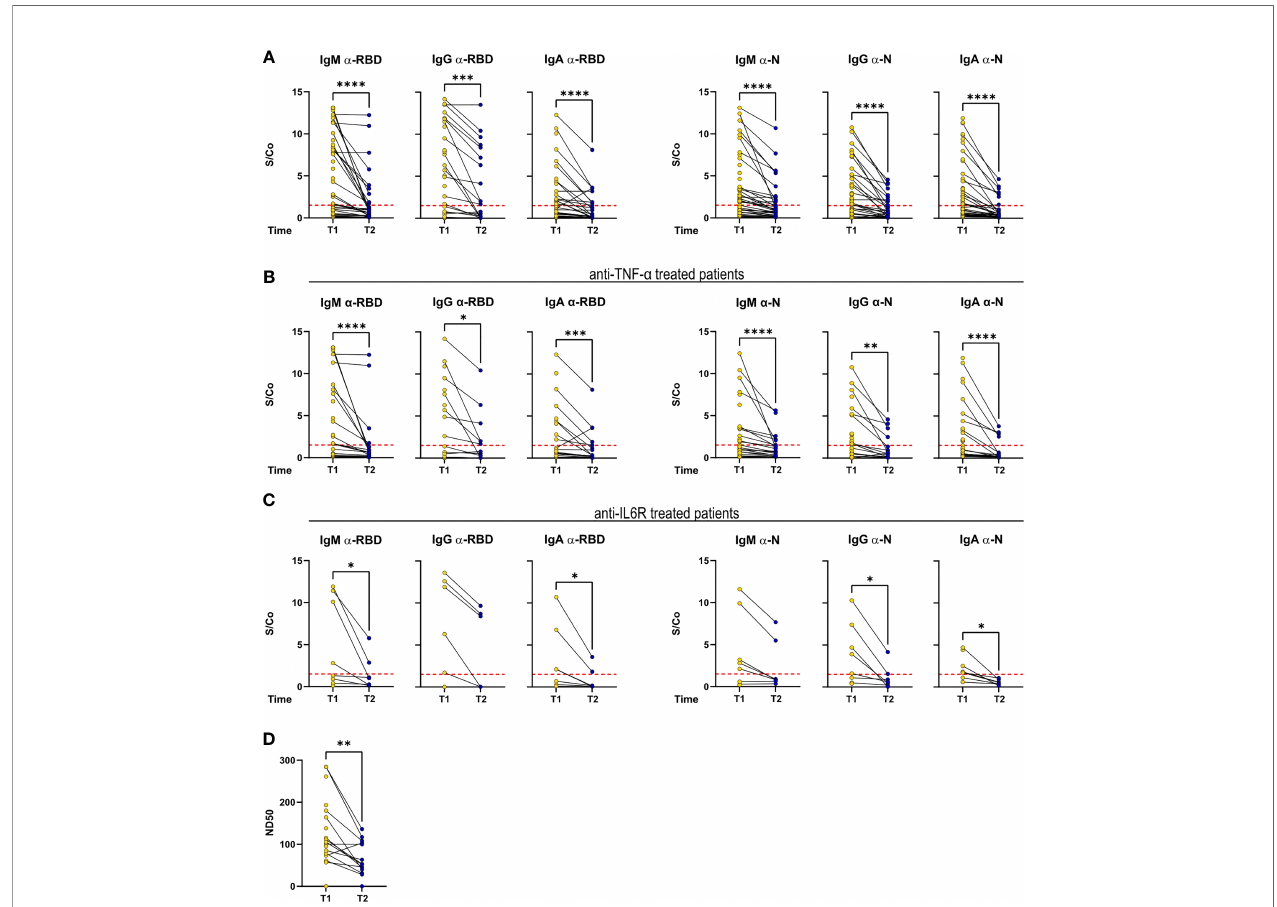
FIGURE 3 | Antibody response is sustained over time in a fraction of RMD patients. IgM, IgG, and IgA levels against RBD and N measured at T1 and T2 in the sera of (A) the whole cohort (T1: N = 68; T2: N = 34), (B) a -TNF- a (T1: N = 37; T2: N = 20), and (C) a -IL-6R-treated patients (T1: N = 8; T2: N = 7). (D) Neutralization titers in sera of RMD patients at T1 ( N = 25) and T2 ( N = 17). Graphs show individual values, means, and SD. Data from the same patients are linked with a line. Statistical signi fi cance was determined using two-tailed Wilcoxon test for paired. * p < 0.05; ** p < 0.01; *** p < 0.001; **** p <